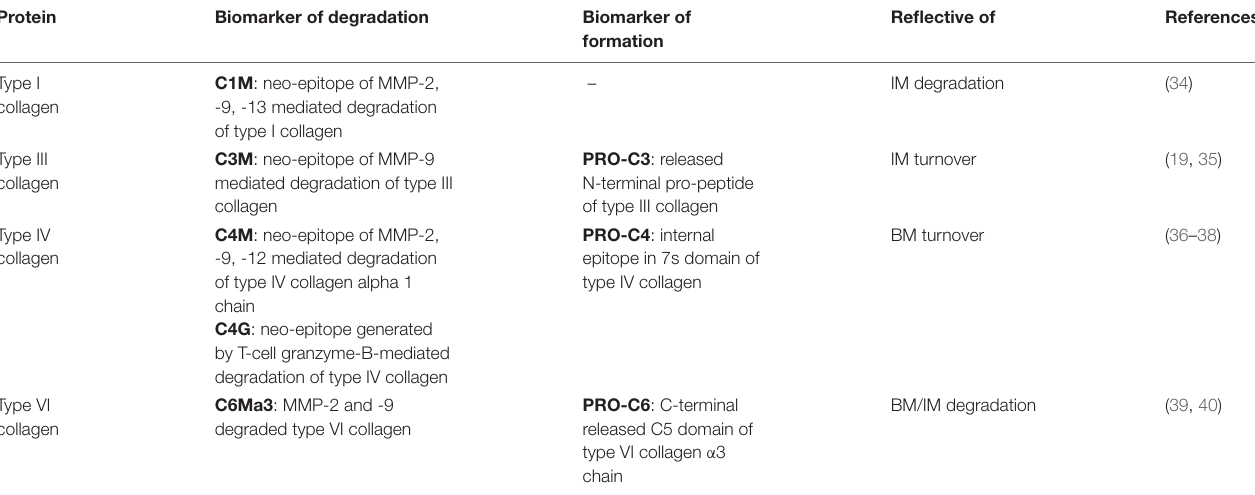
TABLE 1 | Serum biomarkers of extracellular matrix formation/degradation, intestinal inflammation, and immune cell